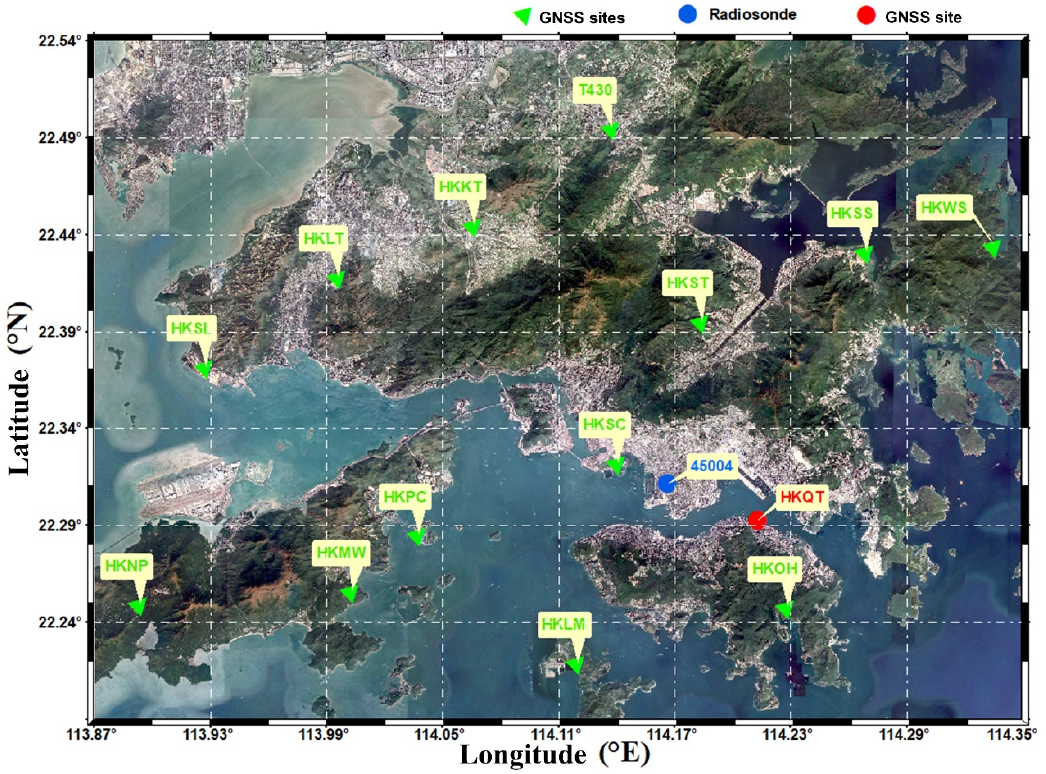
Figure 1. Distribution of GNSS, radiosonde sites, and the horizontal structure of the voxels.